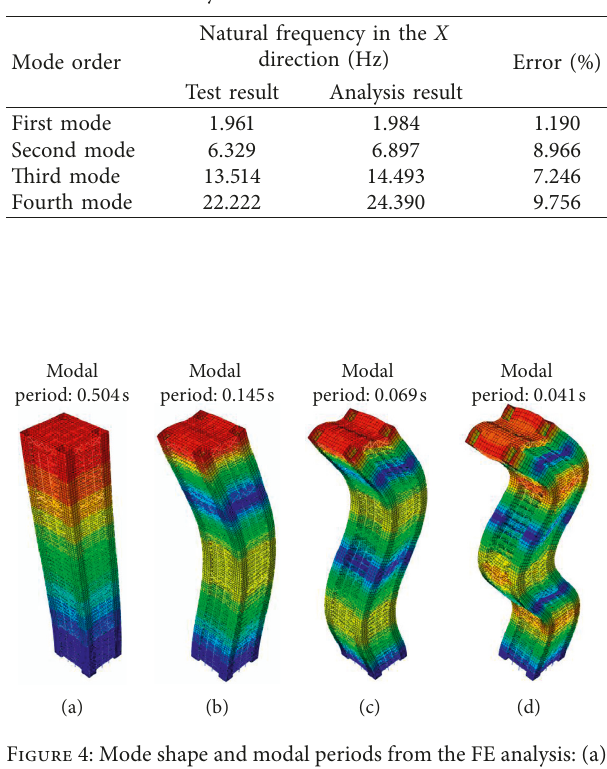
Figure 2: Prototype of the megaframe building and details of the megabeam (unit: mm). Table 1: Comparison of natural frequency in the X direction between test and analysis results.